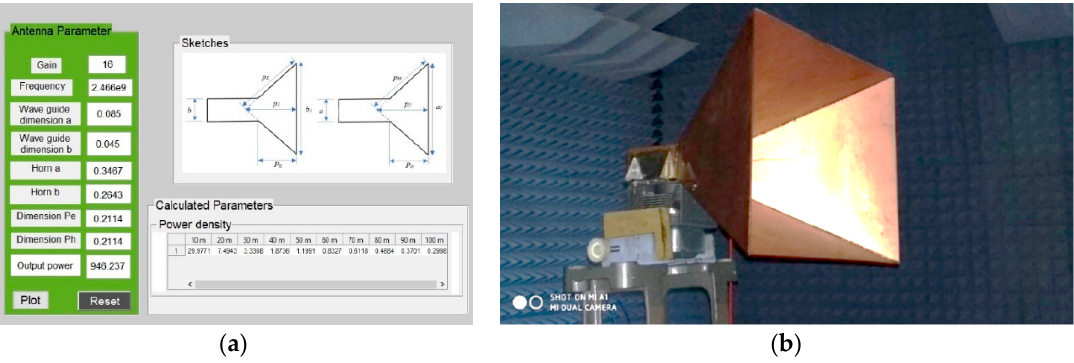
Figure 15. Radiator subsystem design ( a ) program for calculating power density in 10 m to 100 m range; ( b ) testing setup of the antenna in an anechoic chamber.